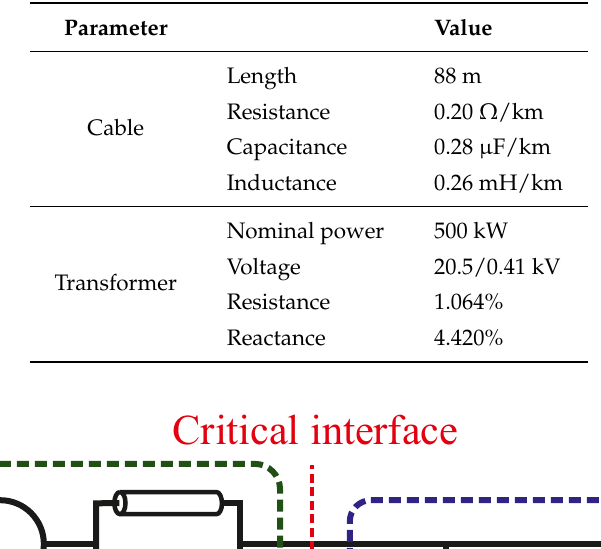
Table 1. Parameters of grid connection.